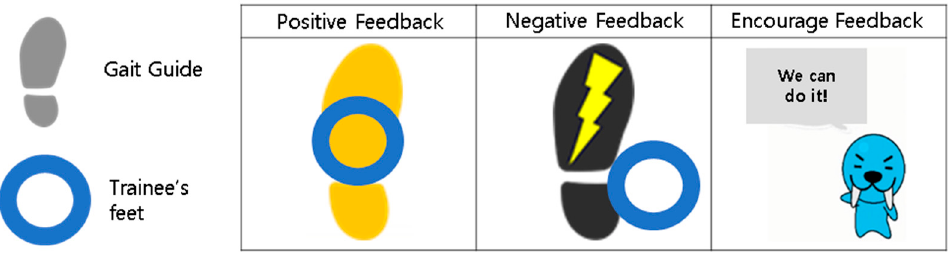
Figure 12. Types of feedback provided during usability evaluation.